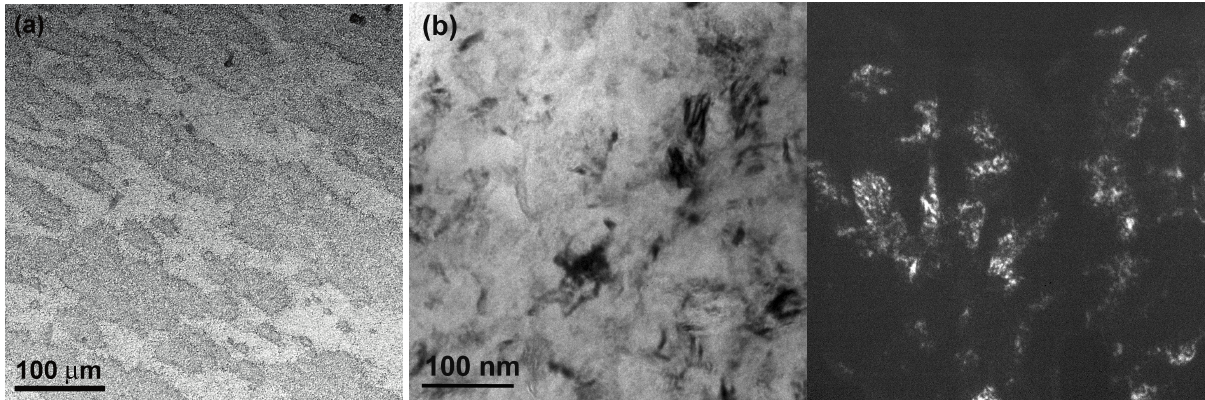
Figure 1. (a) SEM micrograph of the as-cast Zr-2.5 mass% Nb alloy. (b) bright field (left) and dark field (right) TEM micrographs of the HPT-treated Zr-8 mass% Nb